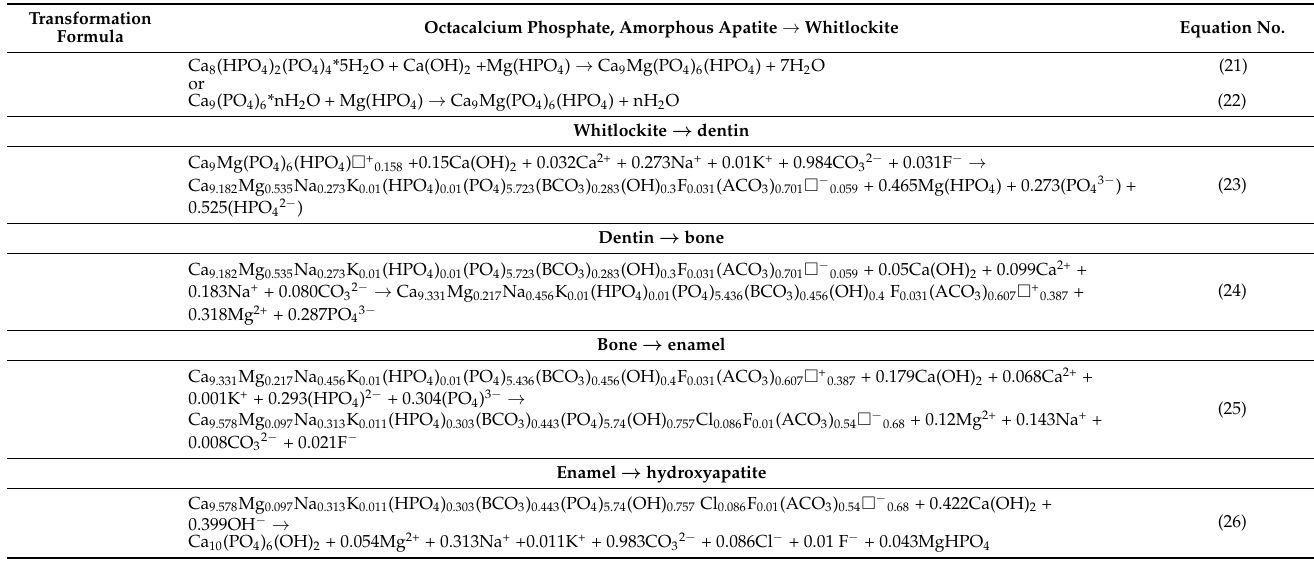
Table 1. Postulated passages from octacalcium phosphate to hydroxyapatite via bioapatites. Transformation → Whitlockite Equation Formula Octacalcium Phosphate, Amorphous Apatite